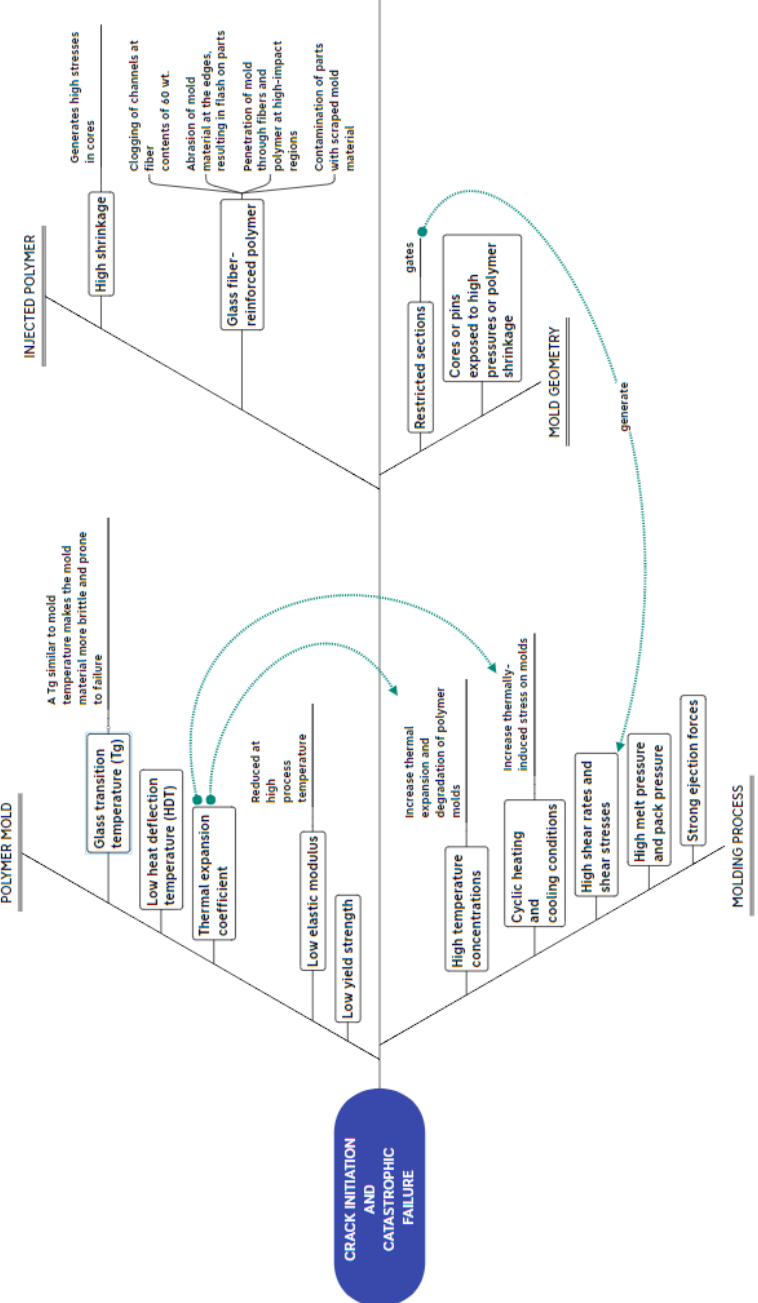
Figure 6. Ishikawa diagram of different sources of crack initiation and catastrophic failure in poly- mer RTIM.